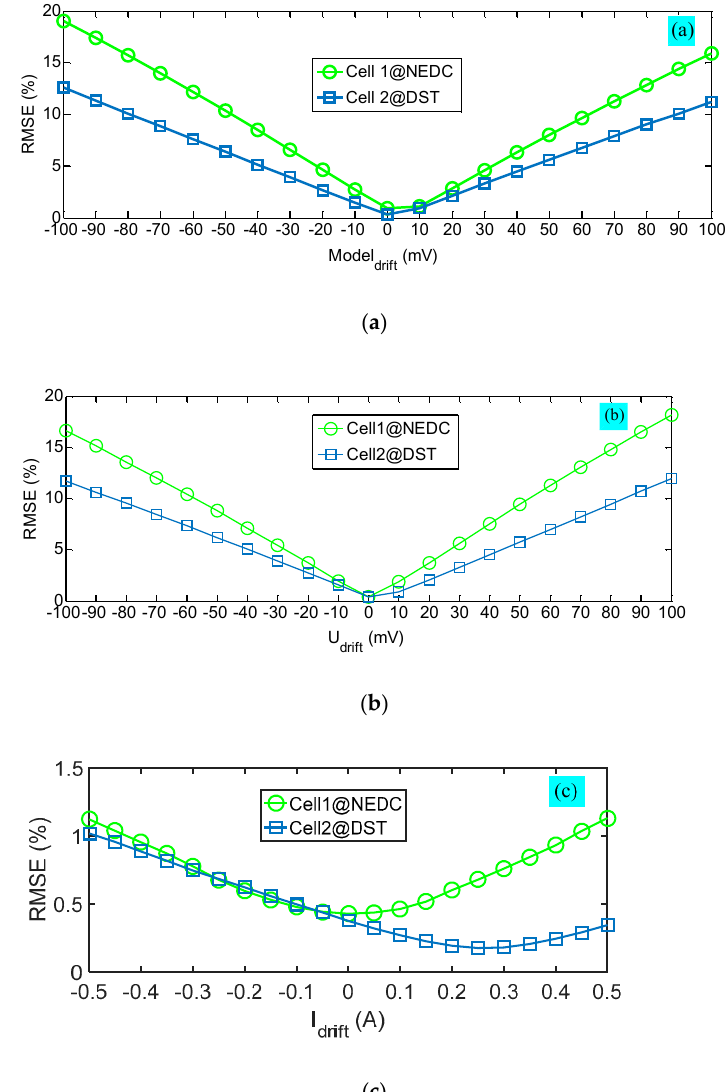
Figure 9. Influence of model and sensor errors on SOC estimated by EKF estimator under NEDC and DST working conditions. ( a ) Relationship between model error and SOC error. ( b ) Relationship between U drift and SOC error. ( c ) Relationship between I drift and SOC